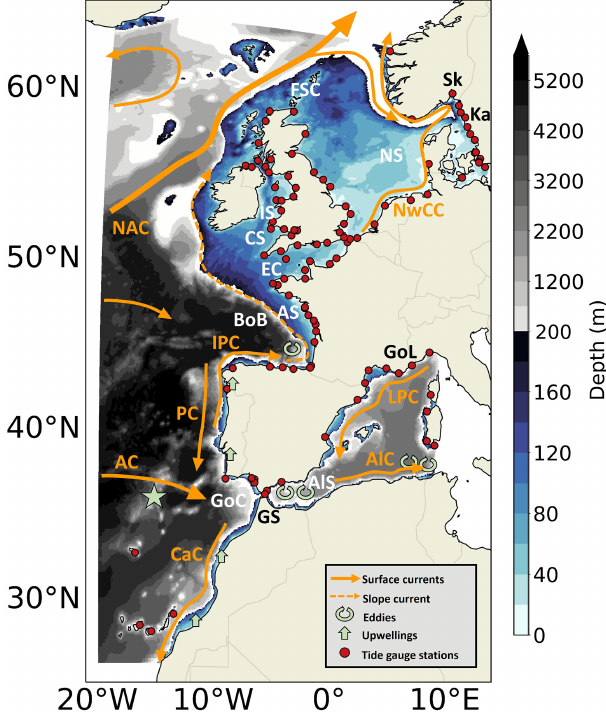
Figure 1. Bathymetry (m) and schematic description of main oceanographic features in the IBI domain. The main surface dy- namical features shown are: the North Atlantic Current (NAC), the Azores Current (AC), the Canary Current (CaC), the Portugal Current (PC), the Iberian Poleward Current (IPC), the Norwegian Coastal Current (NwCC), the Liguro-Provençal Current (LPC), the Algerian Current (AlC). Some geographical features are mentioned: the Bay of Biscay (BoB), the Armorican Shelf (AS), the English Channel (EC), the Irish Sea (IS), the Celtic Sea (CS), the North Sea (NS), the Faroe–Shetland Channel (FSC), the Kattegat (Ka), the Sk- agerrak (Sk), the Gulf of Cadíz (GoC), the Alboran Sea (AlS), the Gulf of Lion (GoL) and the Strait of Gibraltar (GS). The star in- dicates the zone where a temperature–salinity (TS) diagram is per- formed in Sect. 3.1.3. The red dots represent the tide gauge stations of the zone used in Sect. 3.1.6. Note that the color scale for the bathymetry is not linear. The shelf break (defined by the 200m iso- bath) is indicated by the change in the color